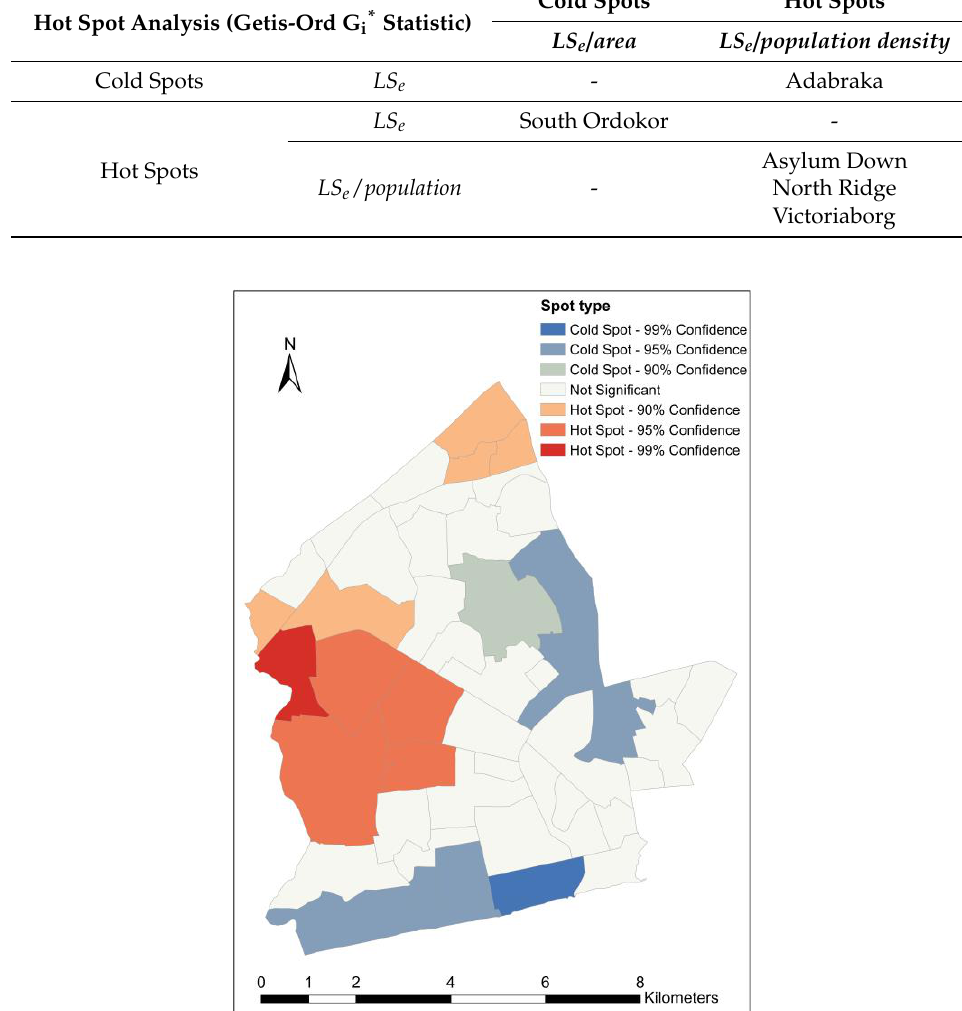
Table 6. Intersecting hot / cold spot neighborhoods for di ff erent load-shedding exposure variables. Cold Spots